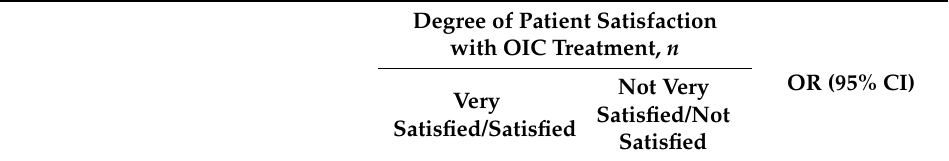
Table 4. Correlation Between Patient Satisfaction with OIC Treatment and Degree of Patient–HCP Communication Regarding BM Symptoms (FAS 1 Population with OIC